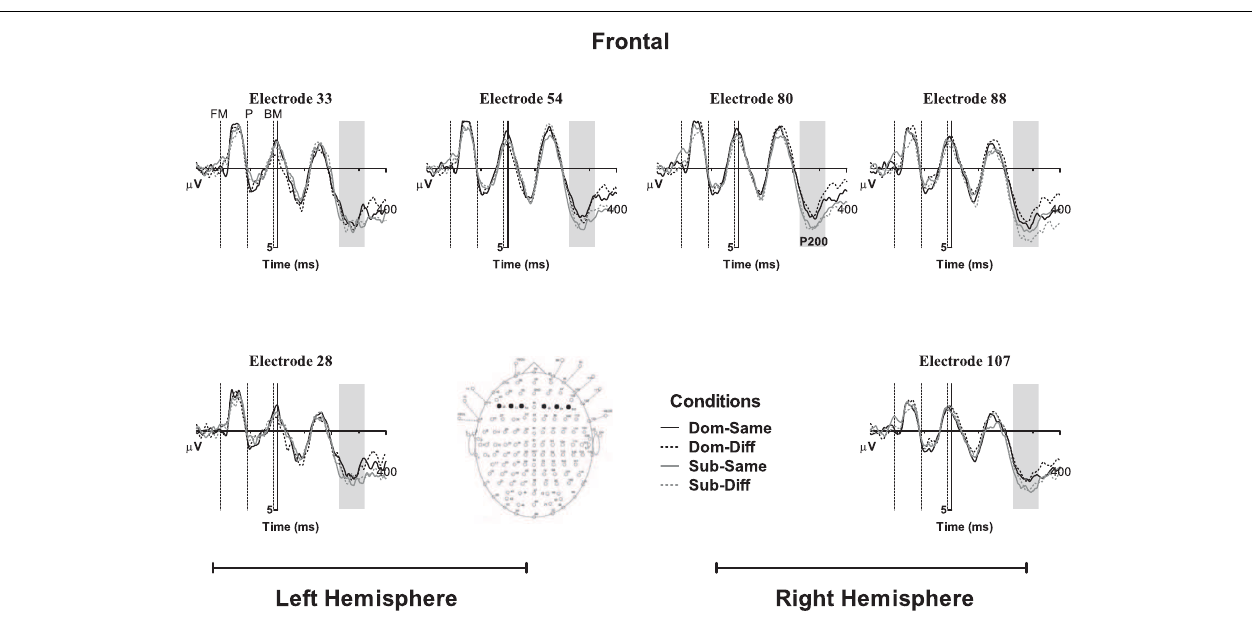
position; Sub-Same, subordinate radical character with prime radical in same position; Sub-Diff, subordinate radical character with prime radical in different position. Dotted vertical lines indicate the onset of the forward mask (FM), prime (P), and backward mask